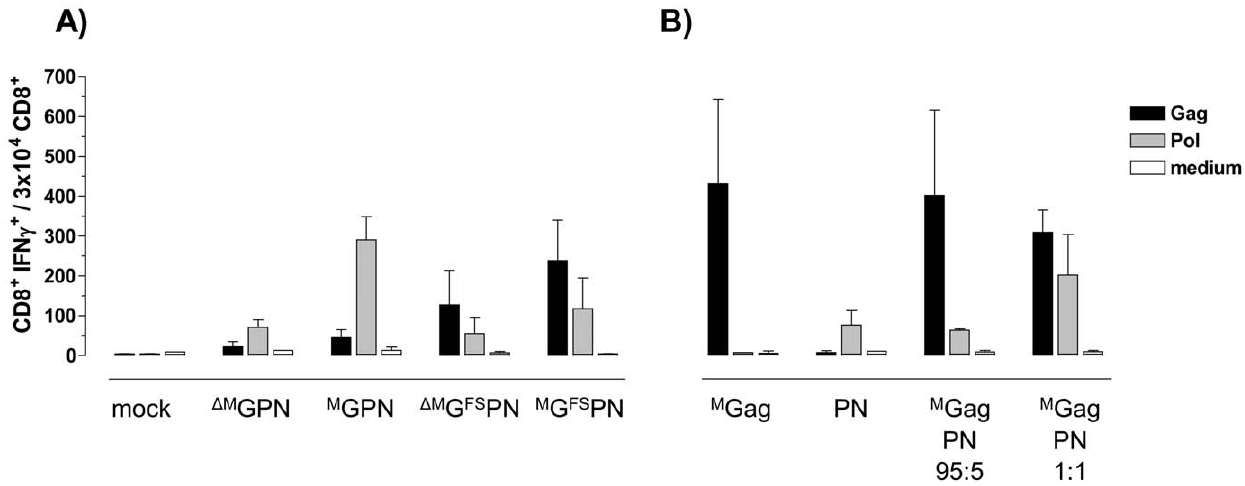
Figure 3. Influence of the modified constructs on Gag- and Pol-specific CD8 + T cell immune responses. BALB/c mice (n=6 per group) were i.m. inoculated with equimolar amounts of the indicated plasmid DNA constructs (80 m g of D M GPN, M GPN, D M G FS PN, M G FS PN; 57 m g of M Gag; 68 m g of PN). After 12 days, spleen cells were isolated and tested for specific cellular immune responses by measuring IFN c production after stimulation with Gag (black) or Pol (grey) specific peptides. IFN c production was determined by FACS analysis after intracellular staining of IFN c . Cell culture medium served as a negative control. (A) Influence of budding competence and the functional frameshift on Gag- and Pol-specific CD8 + T cell immune responses. (B) Impact of separating the Gag and PolNef reading frames on Gag- and Pol-specific CD8 + T cell responses. Data shown are representative of two experiments.